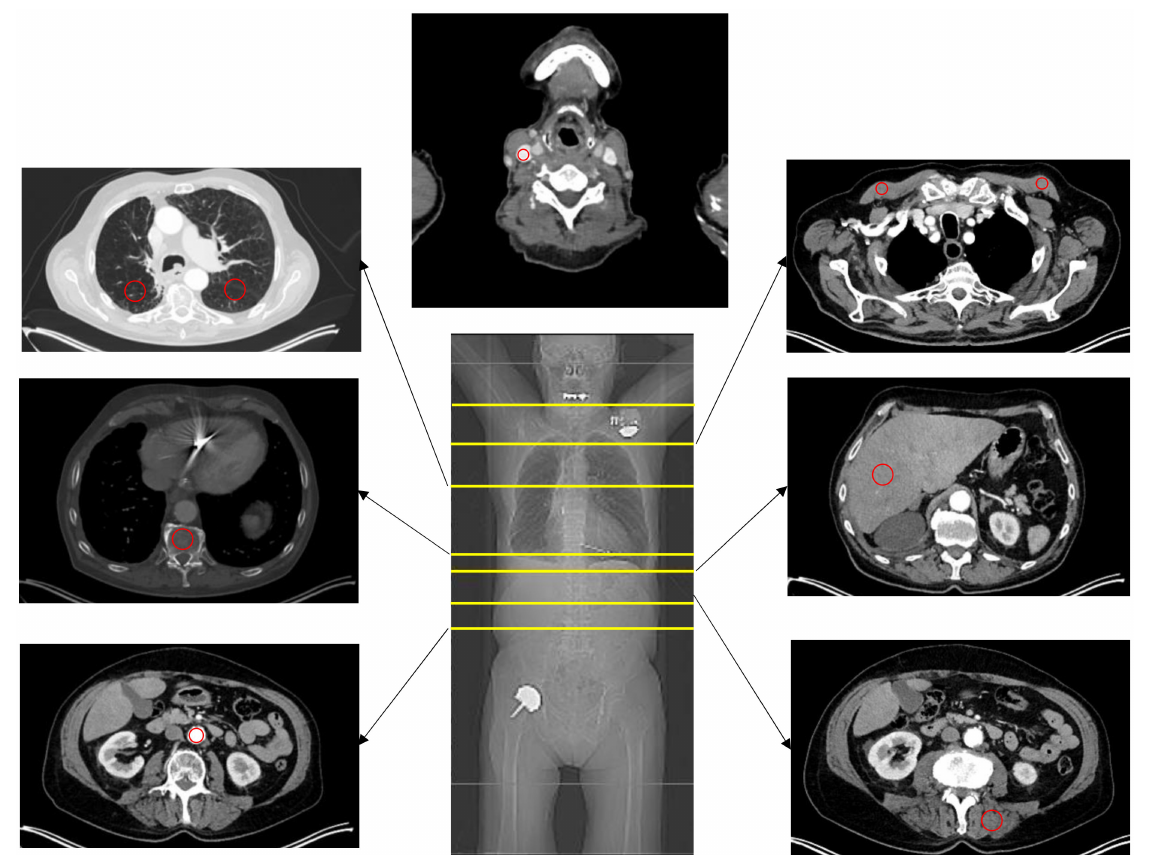
Figure 2. Overview of different measurement localizations. The red circle indicates the localization of the